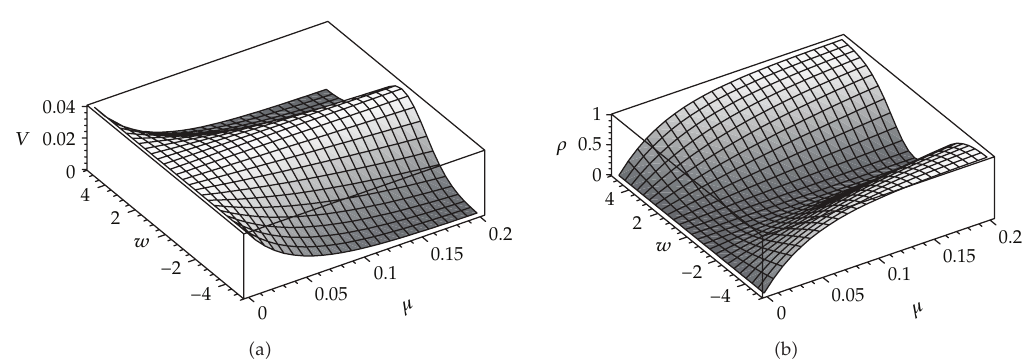
Figure 2: Graph of the variance (cid:3) a (cid:6) and of the correlation (cid:3) b (cid:6) as a function of excess demand and parameter μ